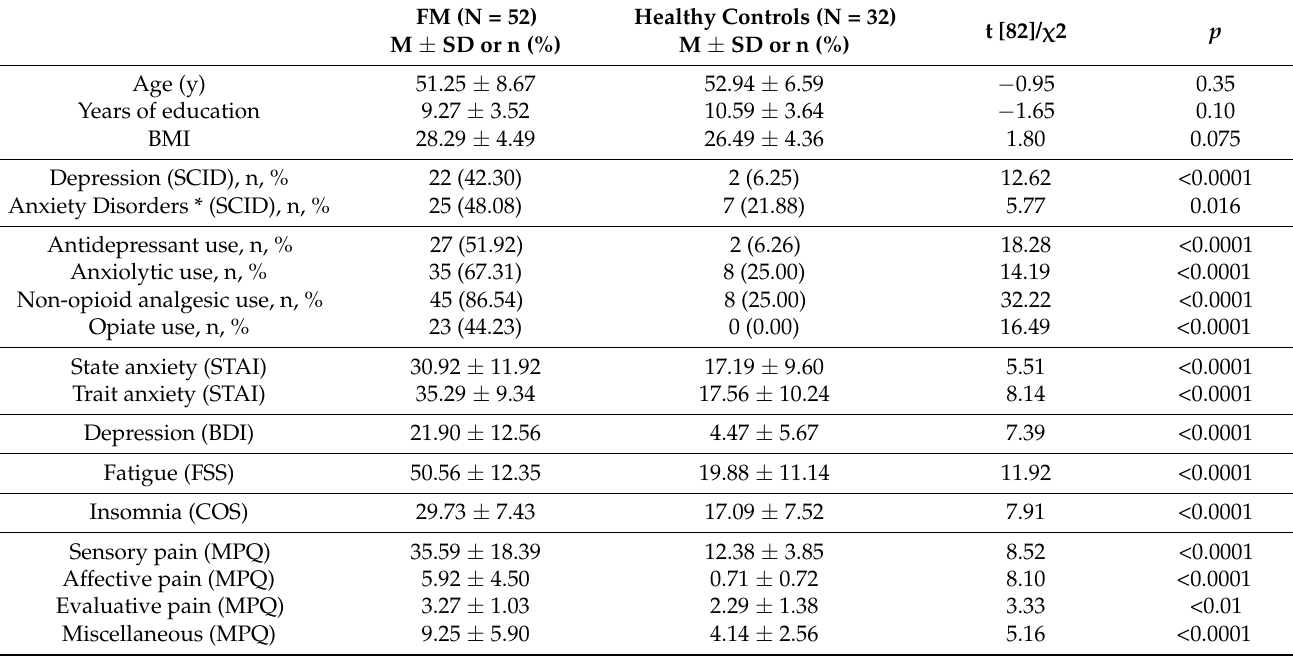
Table 1. Means (M) and standard deviations (SD) of the clinical and sociodemographic data of fibromyal- gia (FM) patients and healthy controls. Results of group comparisons (t or χ 2) are also